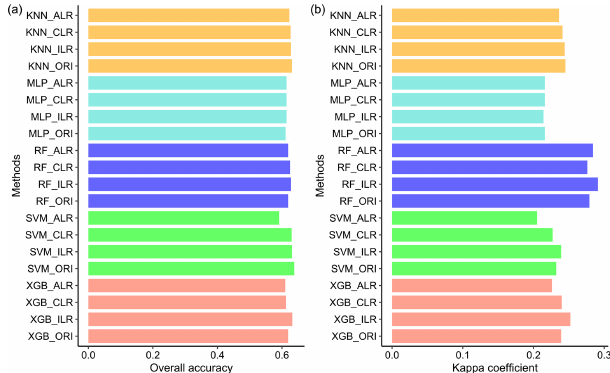
Figure 7. Overall accuracy and kappa coefficients calculated from soil texture classification by soil PSF interpolation using five machine-learning models combined with original data and log- ratio-transformed